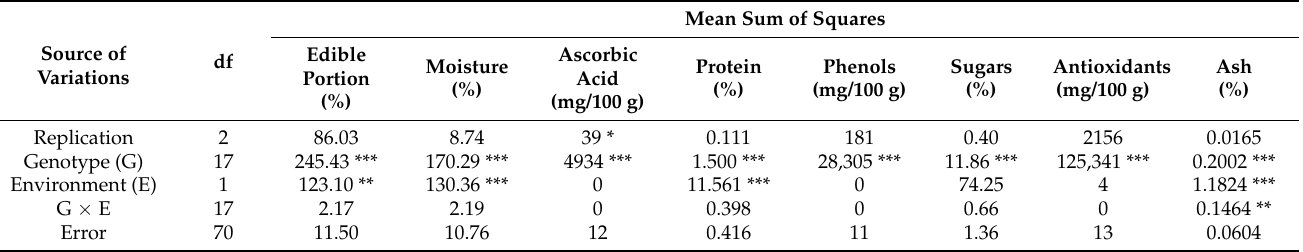
Table 2. Mean sum of squares for different biochemical parameters of the fruits of the 18 genotypes of jujube studied during two-years of study.